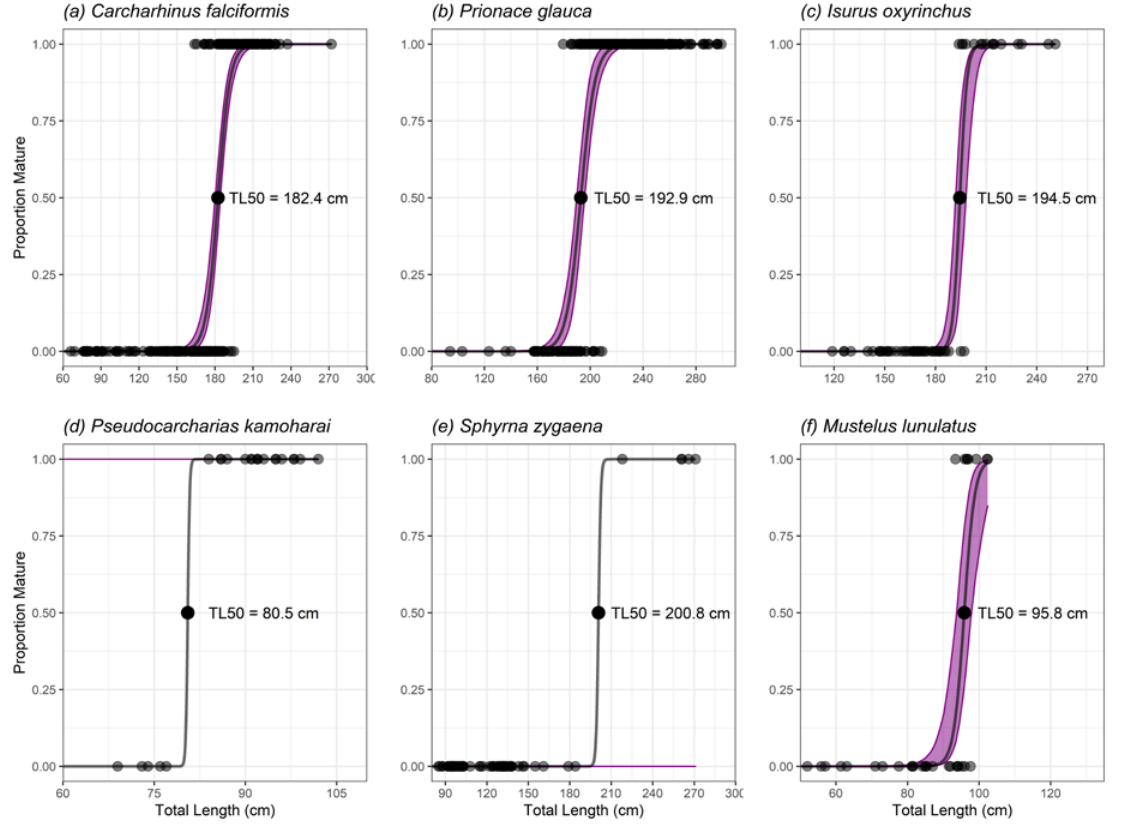
Figure 5. Length at maturity of male individuals of the main shark species landed in Manta: ( a ) Car- charhinus falciformis ; ( b ) Prionace glauca ; ( c ) Isurus oxyrinchus ; ( d ) Pseudocarcharias kamoharai ; ( e ) Sphyrna zygaena ; ( f ) Mustelus lunulatus . The black dots in the middle of the curve correspond to the length at which 50% of individuals have reached sexual maturity (TL 50 ). The black dots at the top and bottom correspond to mature and immature individuals, respectively. The purple shaded areas represent the 95% bootstrapped confidence